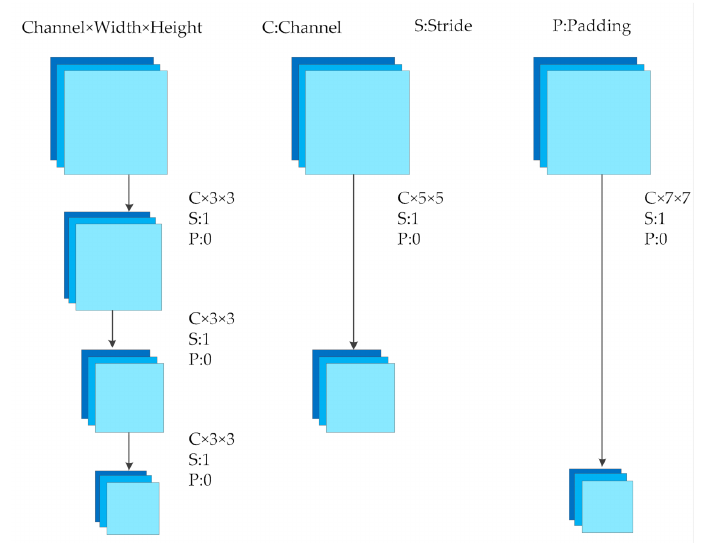
Figure 2. Different size convolutions and stacked